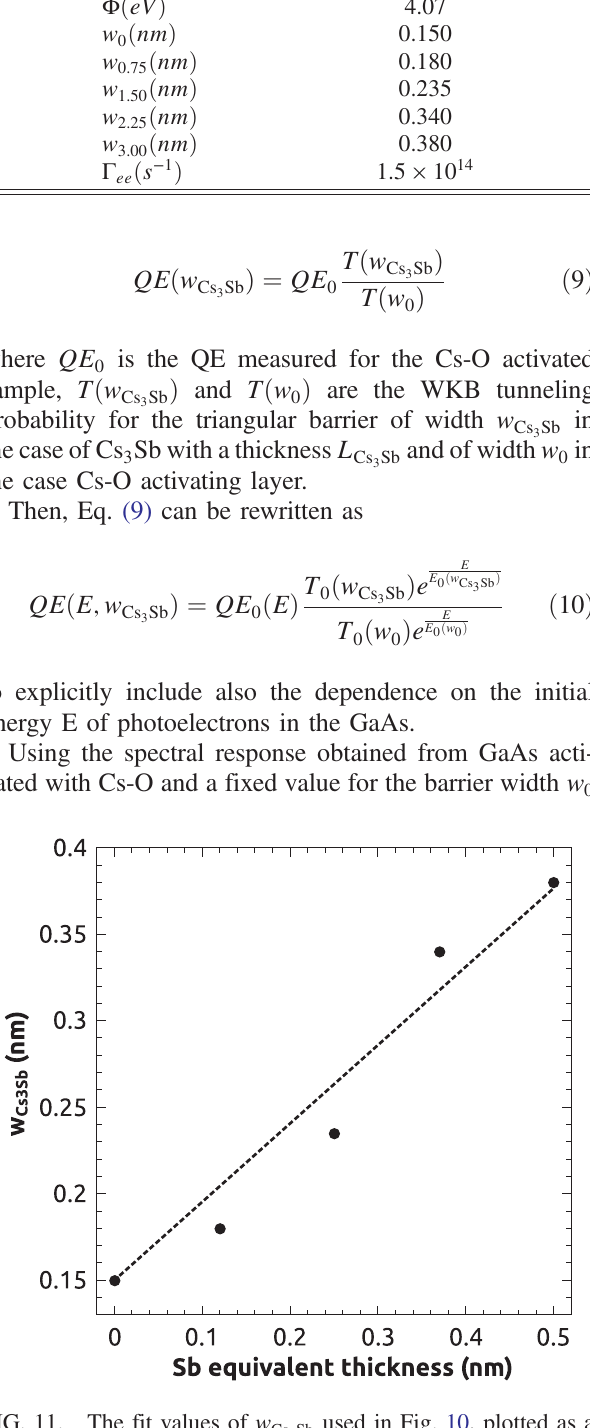
FIG. 11. The fit values of w used in Fig. 10, plotted as a Cs 3 Sb function of the equivalent thickness of the Sb layer. A roughly linear trend is noted, supporting the conclusion that a thicker activating layer weakens the electric dipole at the interface between GaAs and Cs